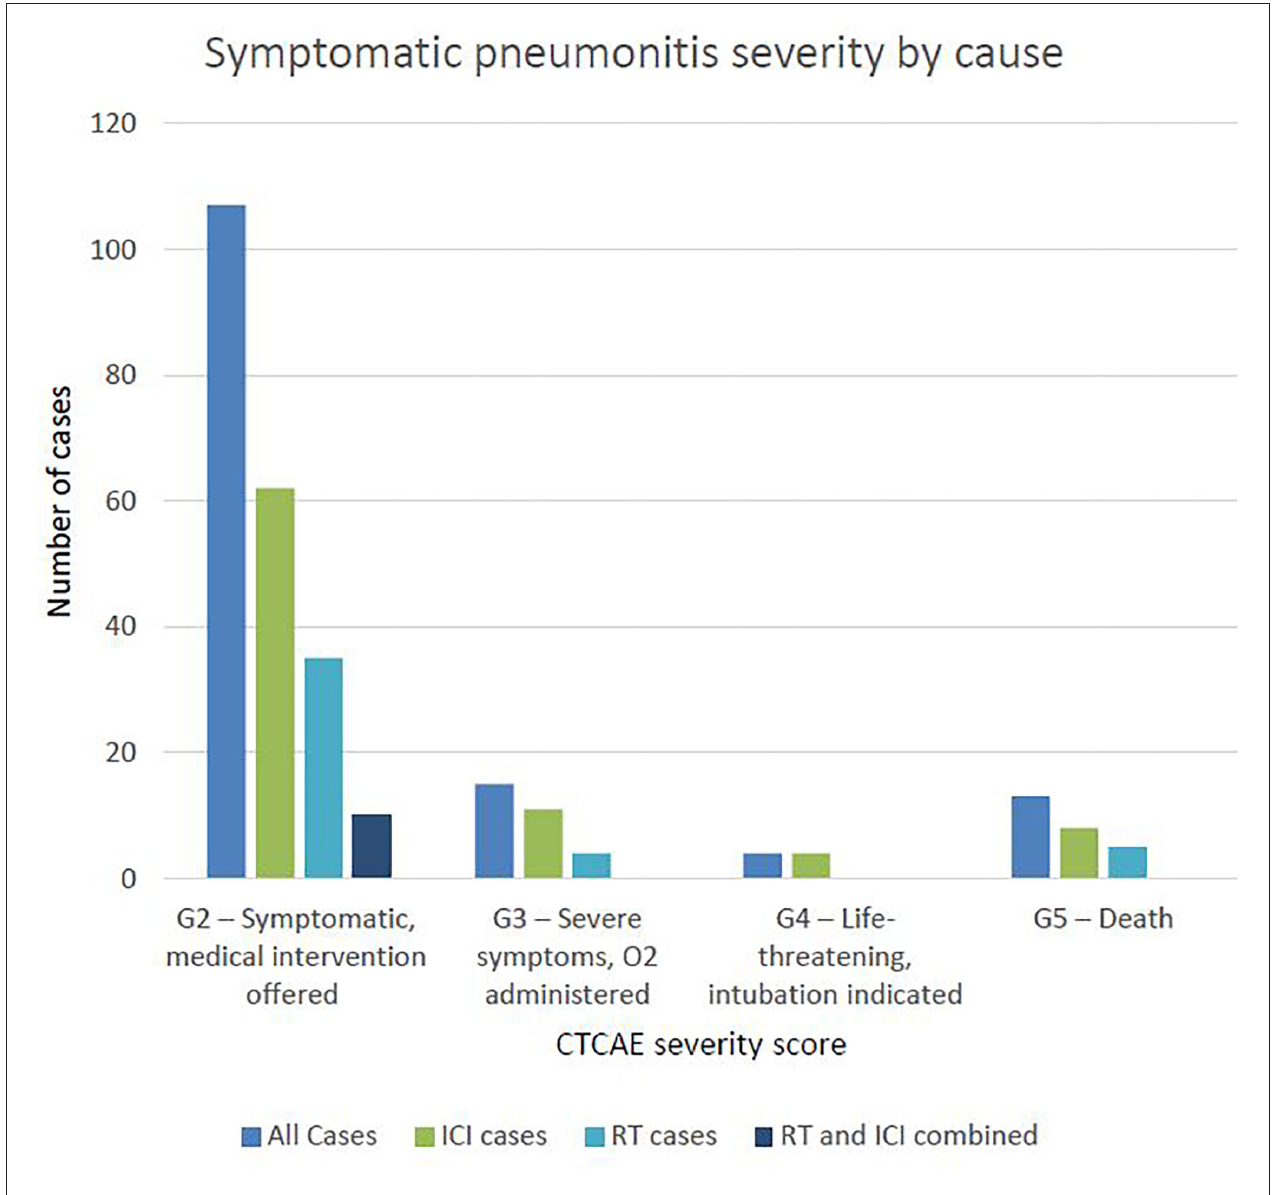
FIGURE 2 | Symptomatic pneumonitis severity by